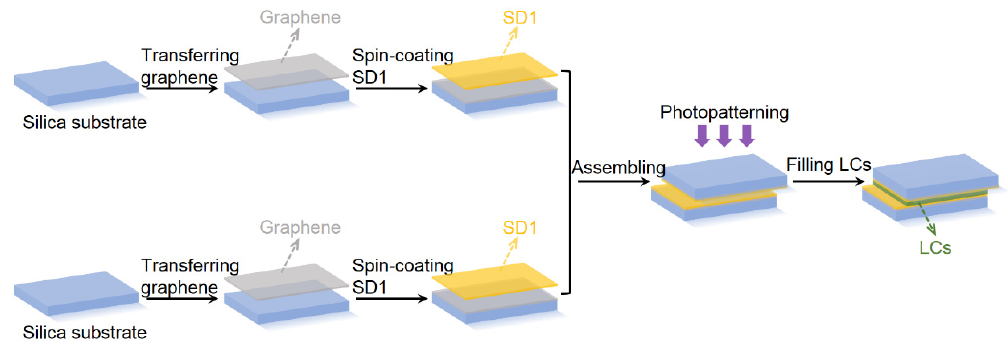
Figure 2. Schematic of the sample preparation process.